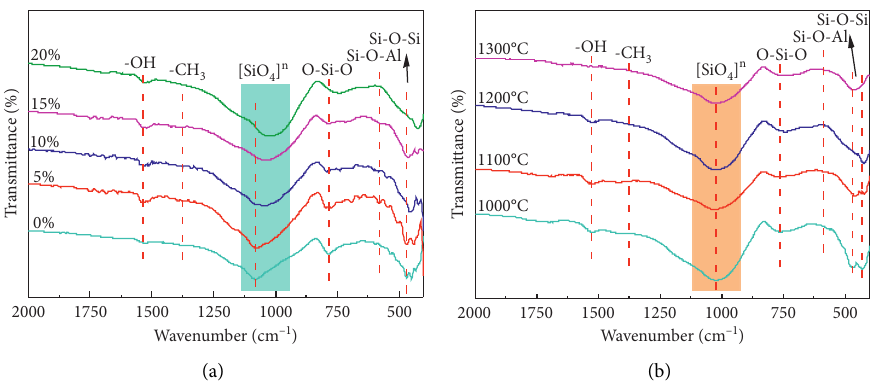
Figure 4: FT-IR spectra of samples: (a) different contents of Na